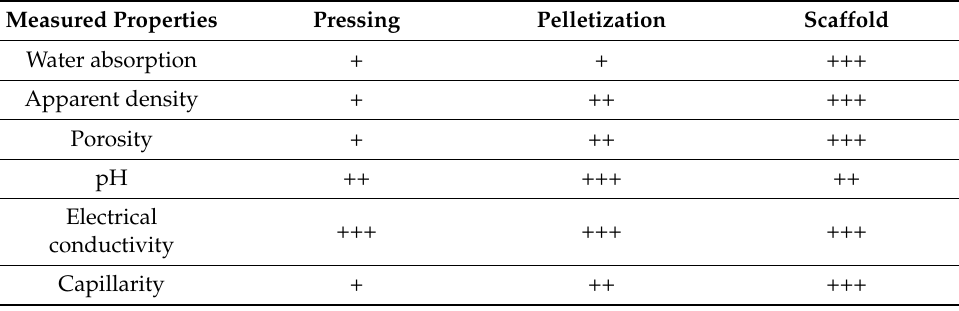
Table 4. Schematic comparison of the measured properties for the three studied